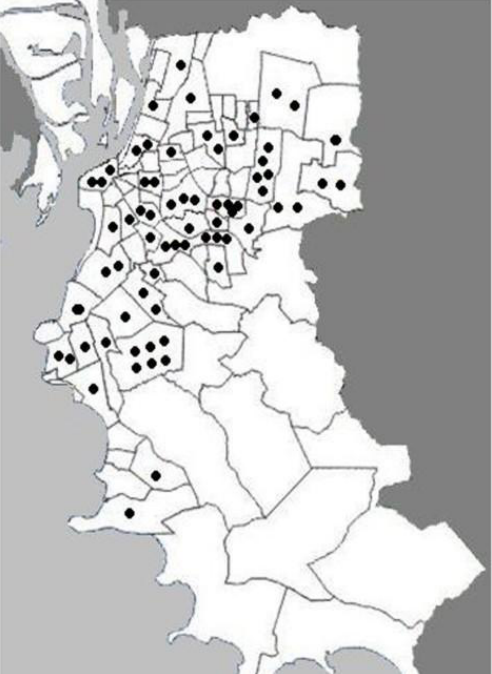
Figure 1. Geographic distribution of the households from the post-infarction patients enrolled in this study within the city of Porto Alegre, Brazil. The delimited areas represent neighborhoods and the dots indicate the location of each household in the